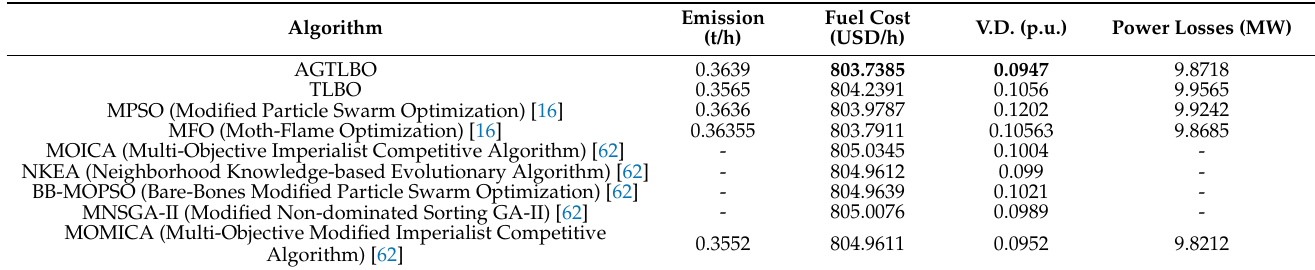
Table 8. Optimal results by different algorithms for Case 7.